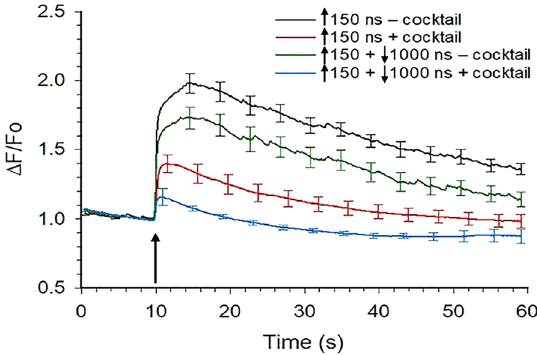
Figure 10. Effect of blocking VGCCs on Ca 2 + responses elicited by asymmetrical bipolar pulses. Averaged cell responses ± s.e.m. for the rise in [Ca 2 + ] i in cells exposed to a 150 ns unipolar pulse vs a ↑ 150 + ↓ 1000 ns bipolar pulse in the presence of a cocktail of VGCC blockers ( + cocktail; n = 7–12), whose composition was identical to that described in Fig. 8, or in the absence of the cocktail ( − cocktail; n = 7–9). Cells were pre-treated with the blockers for one hr at room temperature. Positive and negative pulse phases of the pulse were set to 3.1 and 0.4 kV/cm, respectively, and the arrow indicates when the pulse was applied to the cells. * p < 0.05, significantly different from the response triggered by the corresponding 150 ns unipolar pulse. The arrow indicates when the pulse was delivered to the